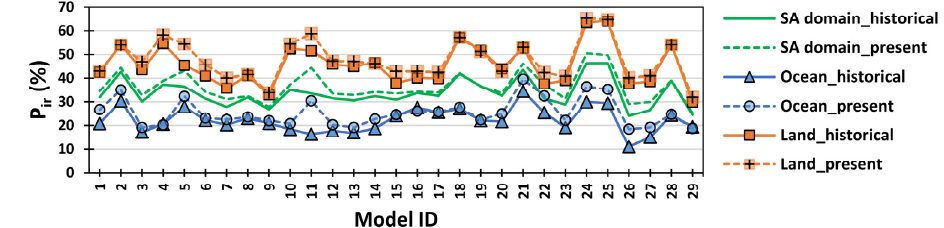
Figure 4. As in Figure 2, but summaries of the climate model’s skill in capturing annual cycle pattern; the percentage of statistically insignificant positive correlation coefficient (P ir , %) is on the y-axis and Model ID is on the x ‐ axis.